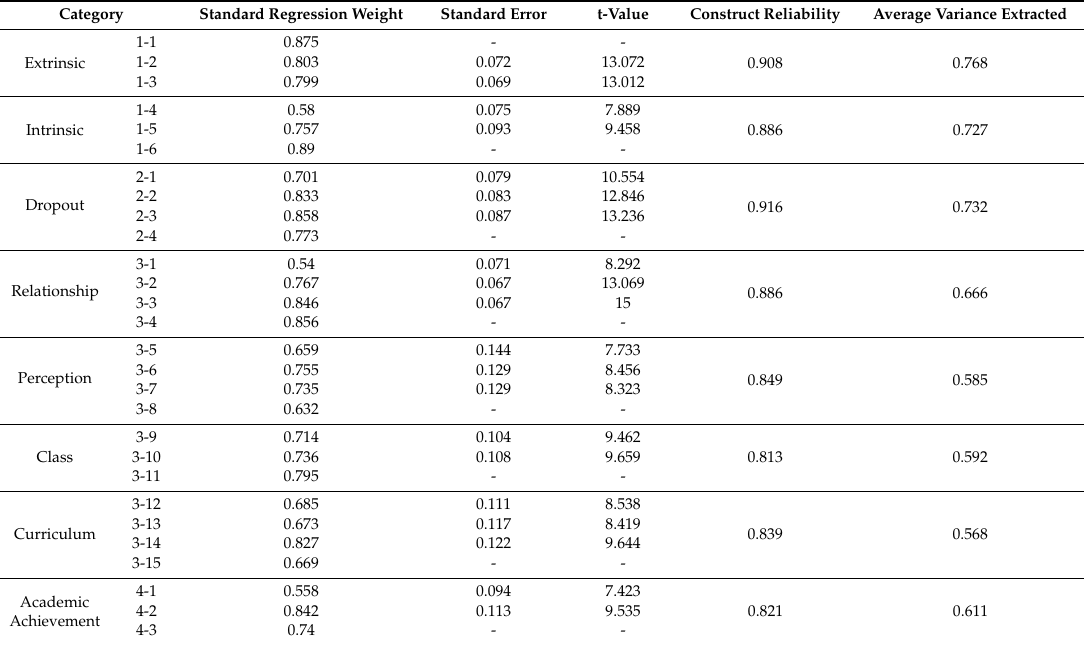
Table 4. Confirmatory Factor Analysis